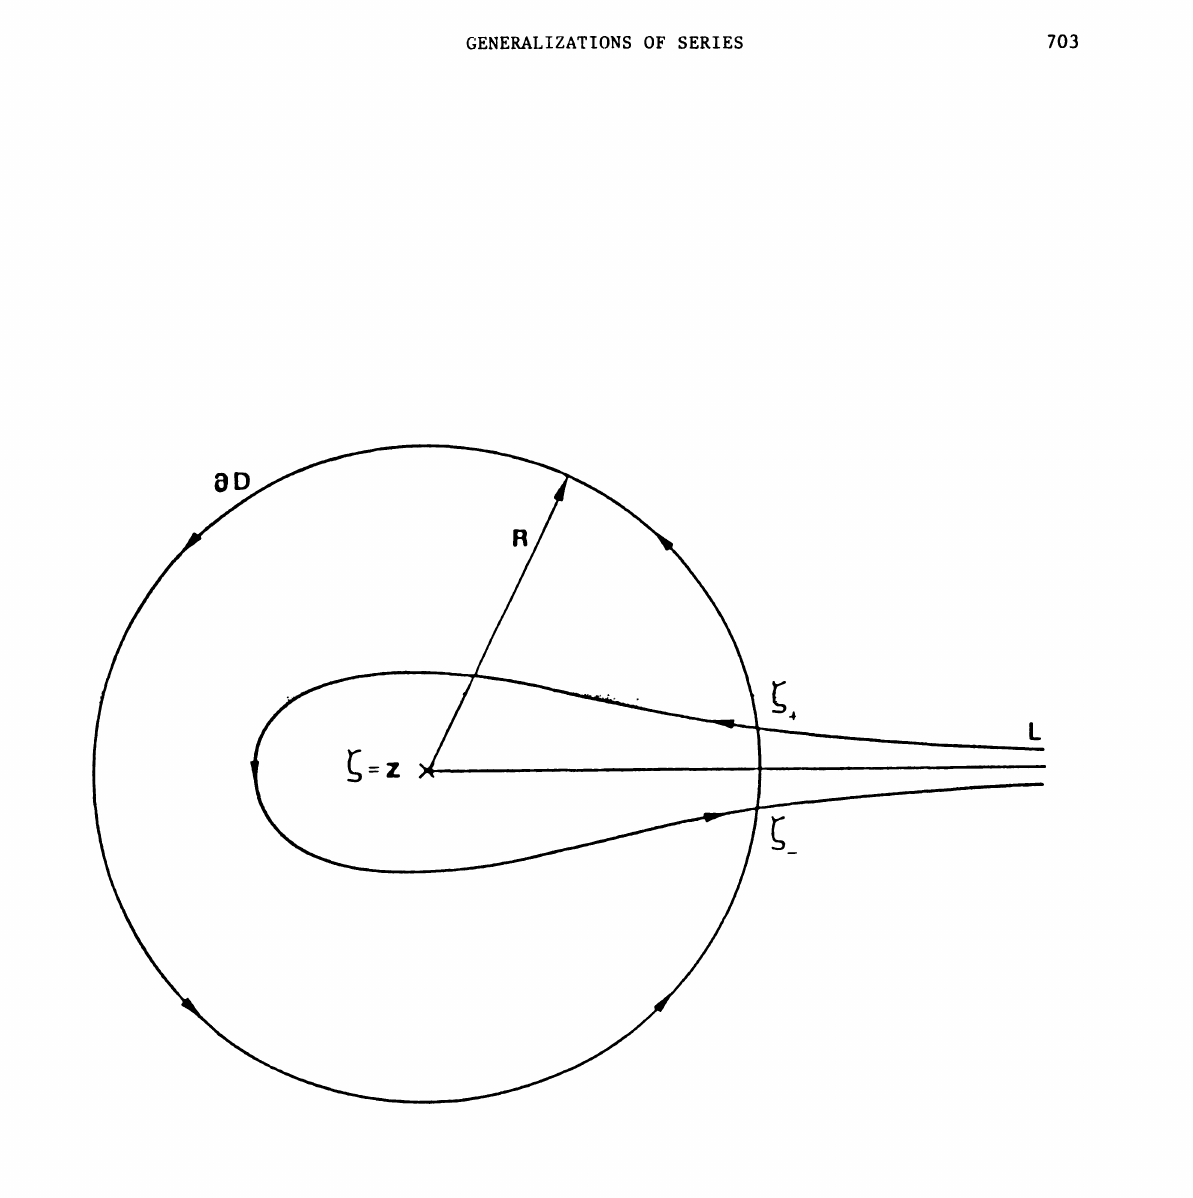
Figure 1 The Hankel loop L used in the ’Liouville’ differintegration of a function =z, analytic at touches at the points +, the boundary D of the region of convergence of the generalized Lagrange series, which is assumed to be a closed loop, which becomes a circle of radius R in the particular case of the generalized Taylor